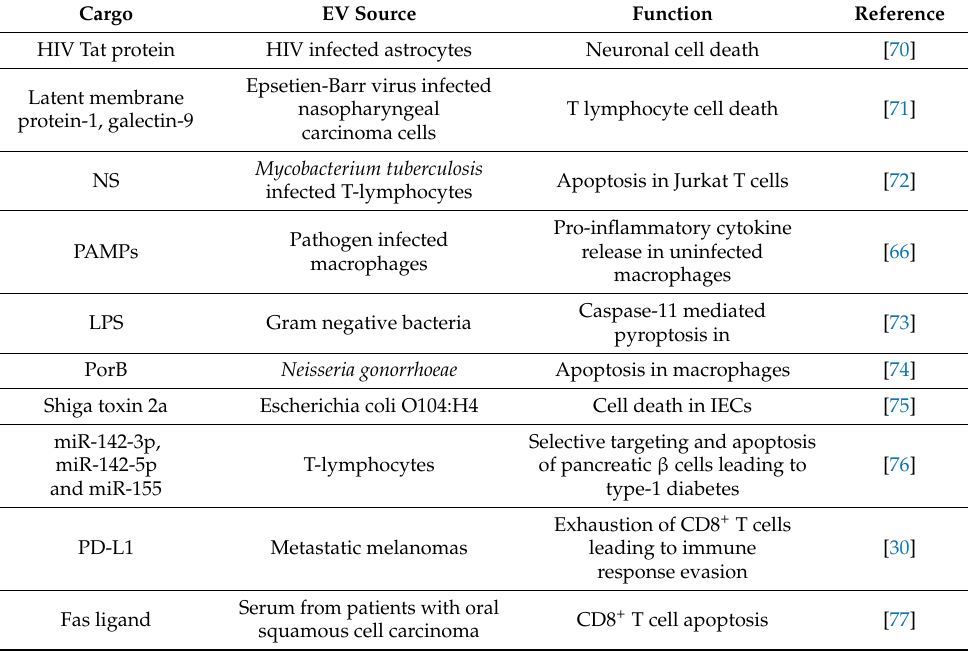
Table 2. Table summarizing the studies which elucidate the role of EVs in promoting cell death. NS—not specified in the original